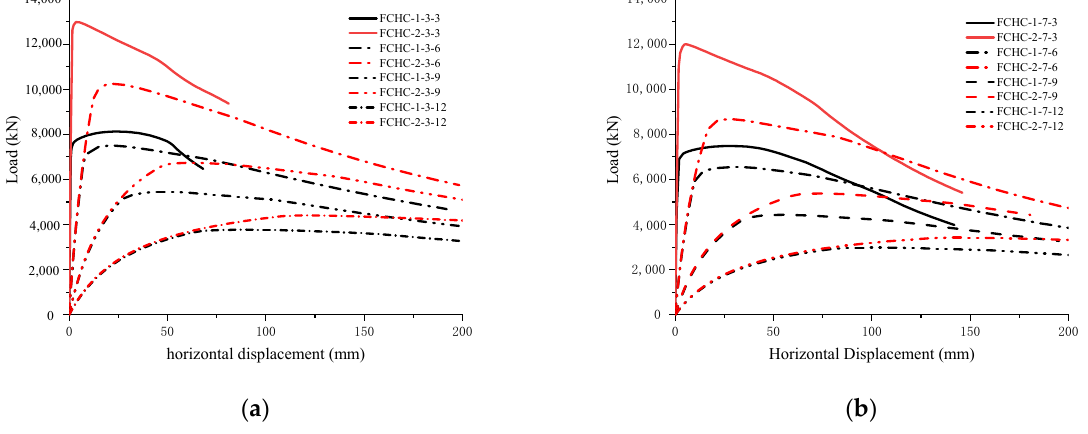
Figure 6. Loading-deformation curves: ( a ) FCHC-X-1 series; ( b ) FCHC-X-7 series.